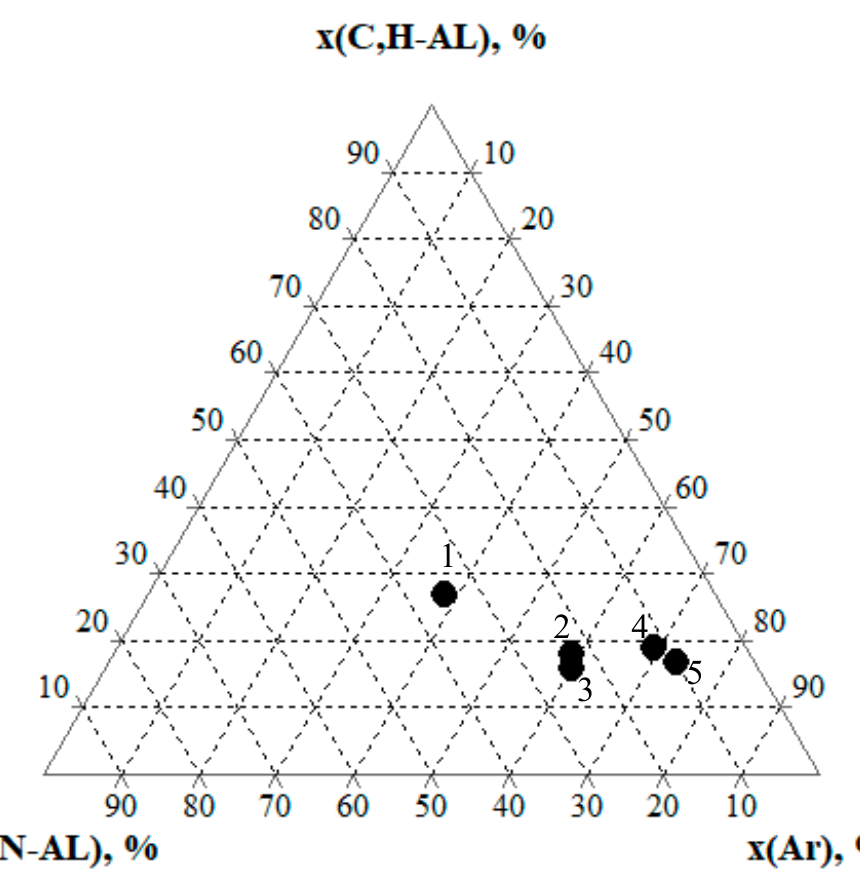
Figure 6. Diagram of structural and functional composition of HSs from studied soils. Sample No. corresponds to Table 1: 1—Control; 2—Crown fire, 2010; 3—Surface fire, 2010; 4—Crown fire, 2020; 5—Surface fire, 2020.